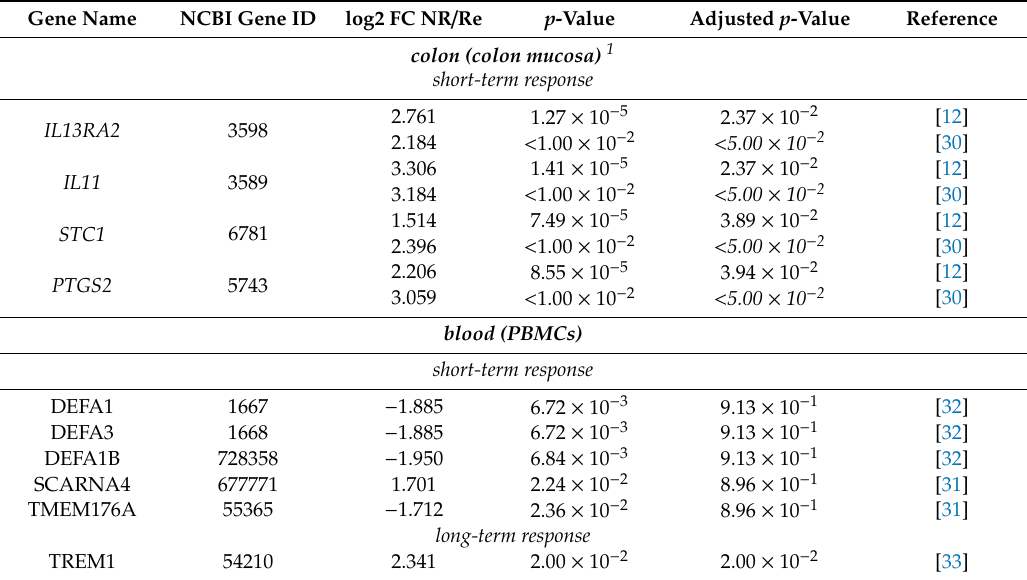
Table 2. RNA markers linked to anti-TNF response in CD